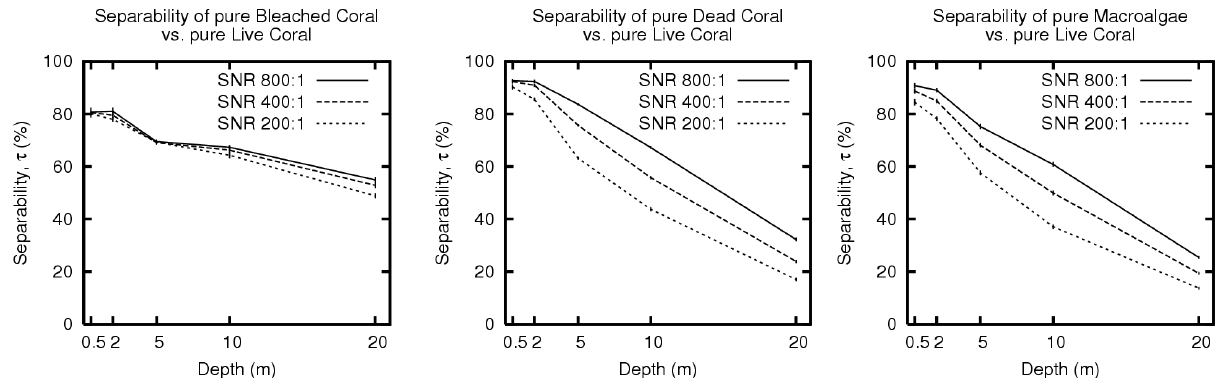
Figure 10. Separability of Bleached Coral, Dead Coral and Macroalgae from pure Live Coral under the three sensor noise classes and Zonal IOP variation as a function of depth. Error bars are  1S.E over the ten repeat